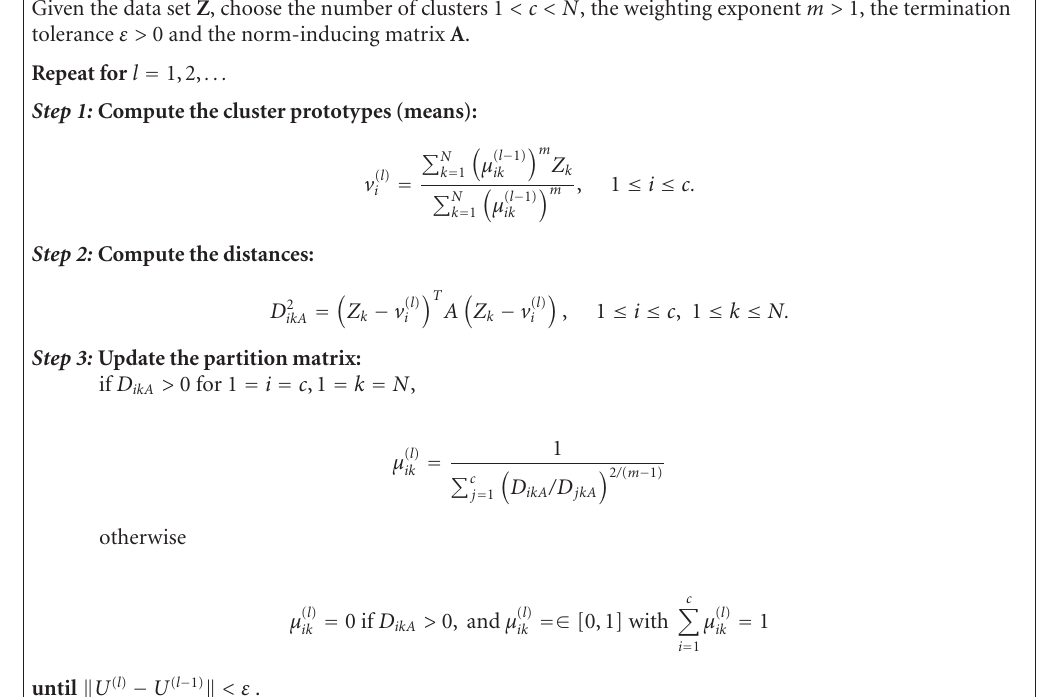
Figure 4: Fuzzy c-means algorithm from